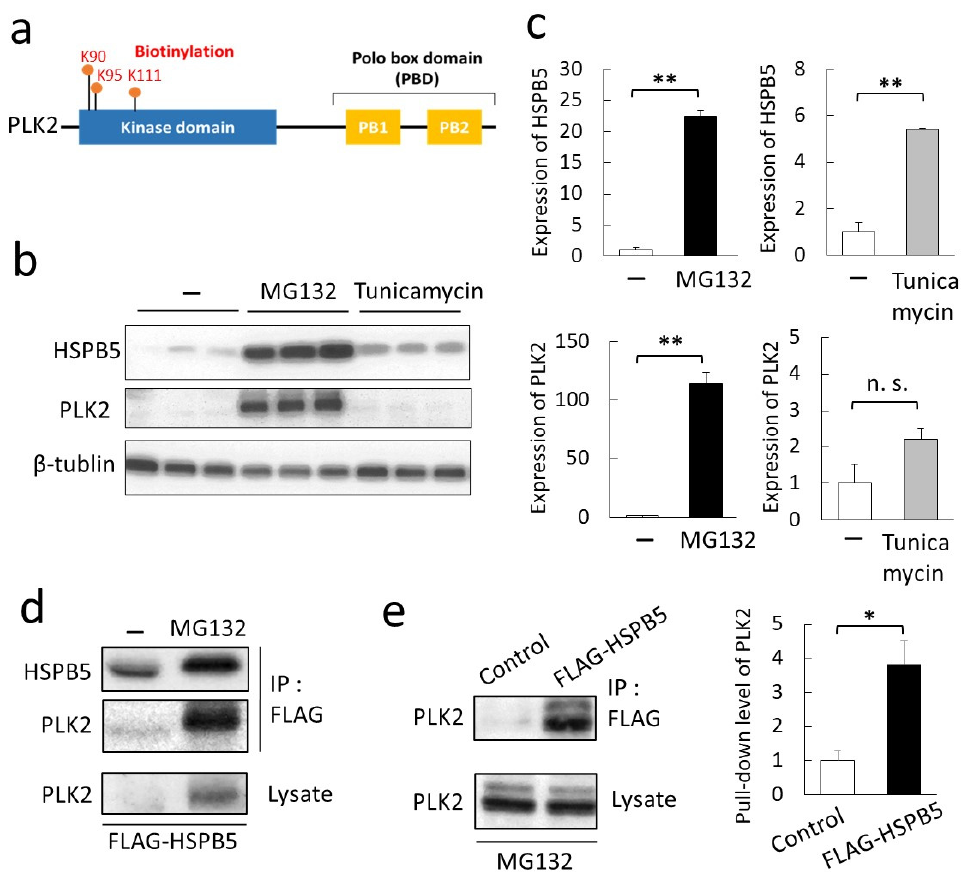
Figure 3. PLK2, a novel binding protein of HSPB5, is induced by MG132 in L6 cells. ( a ) Schematic diagram of domain structure of PLK2. K90, K95, and K111 indicate position of lysine residue (K) biotinylated by HSPB5-BioID2. Lysine residues were numbered based on amino acid sequence of PLK2 derived from Homo sapiens (NCBI NP_006613). ( b ) Comparison of induction of HSPB5 and PLK2 expression by ER stress-induced drugs. Differentiated L6 cells were treated with 5 µ M MG132 or 0.1 µ g/mL tunicamycin for 24 h. Induction of HSPB5, and PLK2 protein expression was detected by Western blotting. ( c ) Graph shows levels of endogenous proteins induced by the drug. Data represent means ± standard error (n = 3). Statistical analyses were performed using t -test. ** p < 0.01; n.s. means not significant. ( d ) Verification of binding of PLK2 to HSPB5. FLAG-HSPB5 was overexpressed in L6 cells by liposome transfection. After 5 µ M MG132 treatment (24 h), cells were solubilized, and HSPB5 pull-down assay was performed using an anti-tag antibody. ( e ) Quantification of binding of PLK2 to HSPB5. Control cells were transfected with empty vector. After 5 µ M MG132 treatment (24 h), a pull-down assay was performed using an anti-tag antibody. Graph presents level of endogenous PLK2 pulled down by HSPB5. Data represent means ± standard error (n = 3). Statistical analyses were performed using t -test. * p <